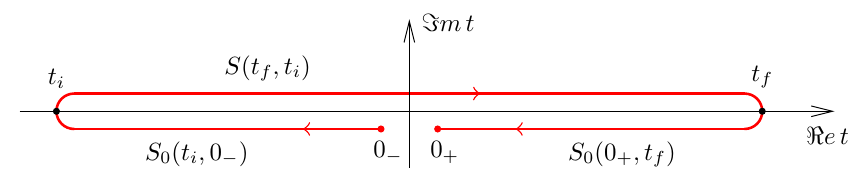
Figure 3 . Time contour in the path integral for the scattering